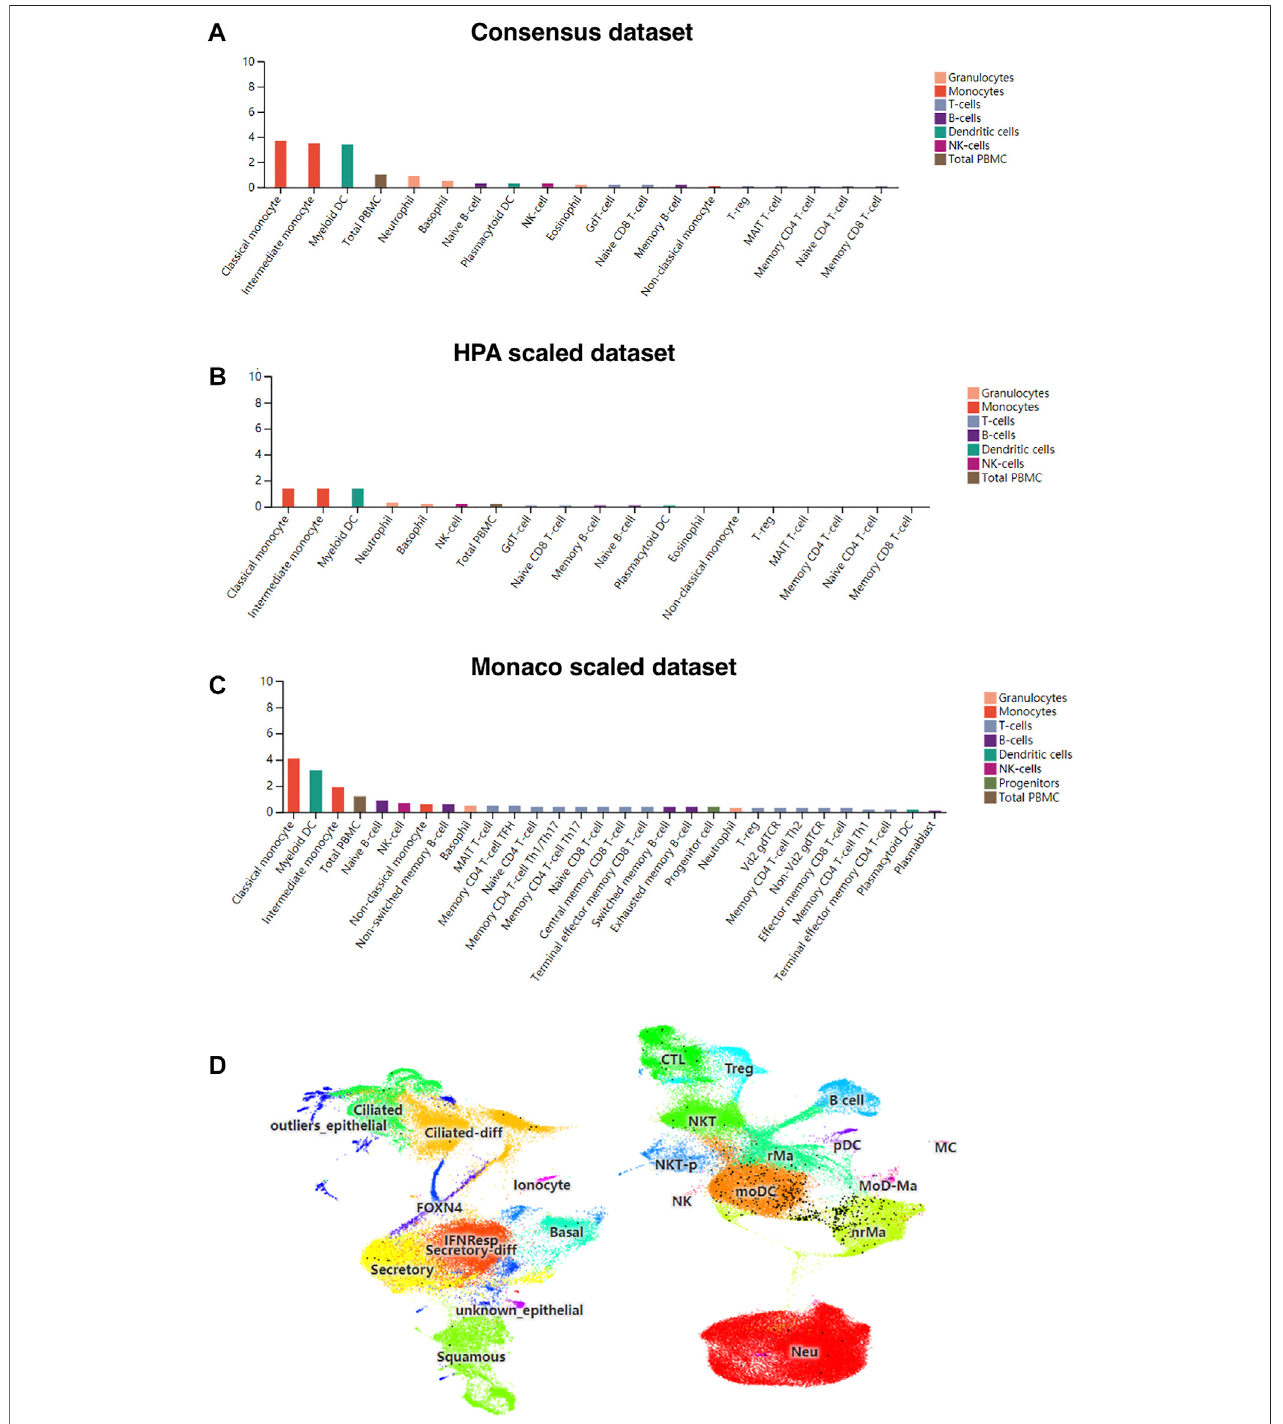
FIGURE 4 | CD209 expression in human blood cells and nasopharyngeal cells in different datasets. (A) Consensus dataset, (B) HPA dataset, and (C) Monaco dataset. (D) Single-cell RNA-seq data for CD209 expression in nasopharynx immune cells of COVID-19 patients was downloaded from the UCSC cell browser portal (http://www.cells.ucsc.edu/). Each black dot represents the expression of CD209 in different cell types (total 135,600 cells). Abbreviation: MoDCs, monocyte-like in fl ammatory Dendritic Cells; nrMa, nonresident macrophages.